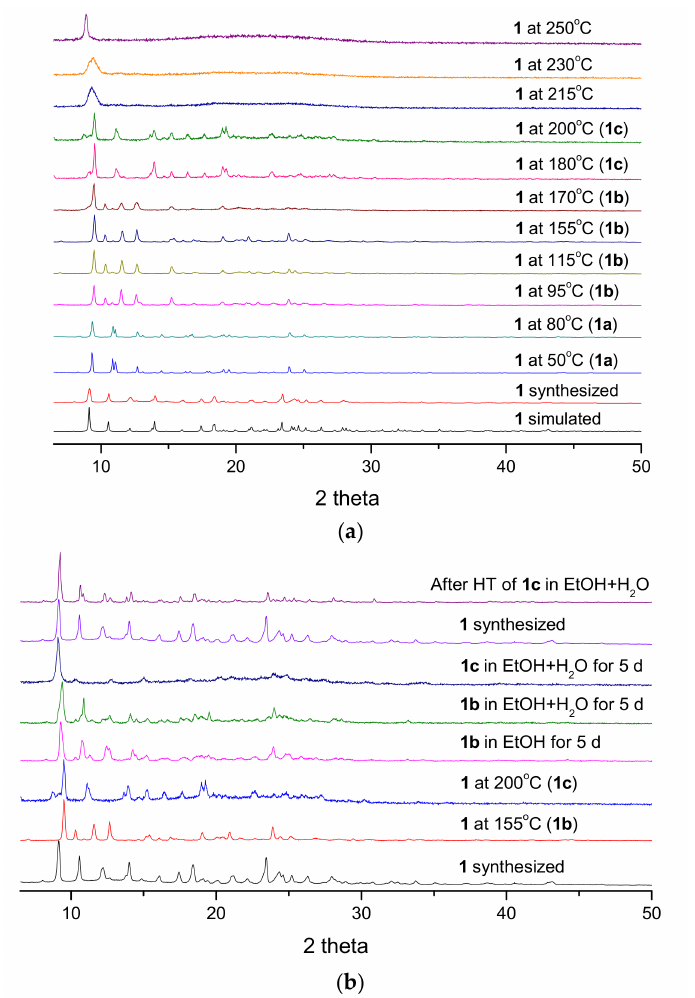
Figure 5. ( a ) Variable temperature powder XRD patterns of 1 showing a series of stepwise structural transformations from 1 to 1a to 1b to 1c ; ( b ) Powder XRD patterns showing reversible structural transformation from 1b or 1c to 1 by applying various